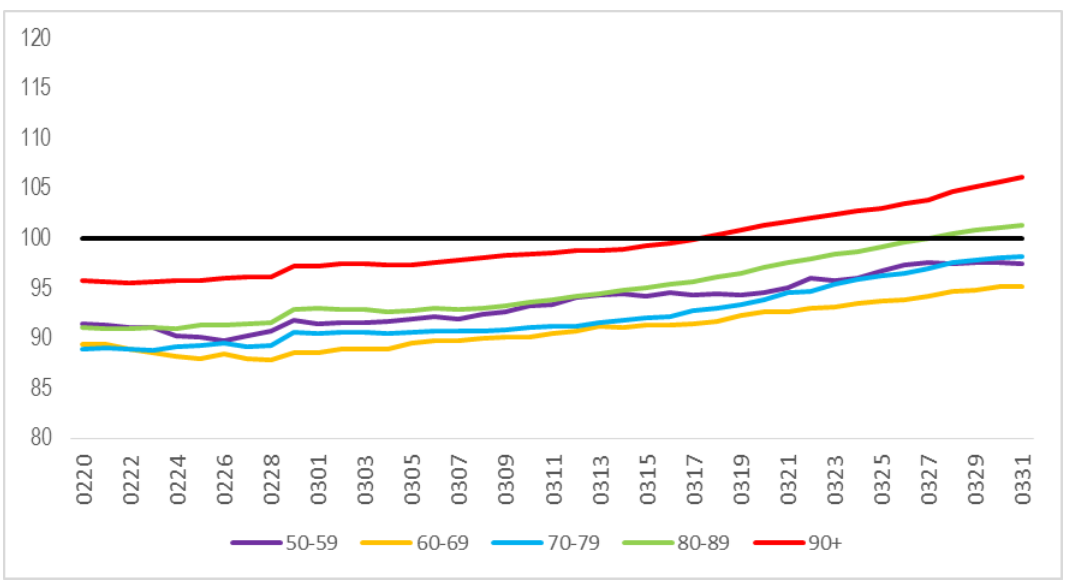
Figura 4. Decessi cumulati a partire dal primo gennaio per classe di età. Per 100 decessi della stessa classe di età della media 2015-2019. Province con medio livello